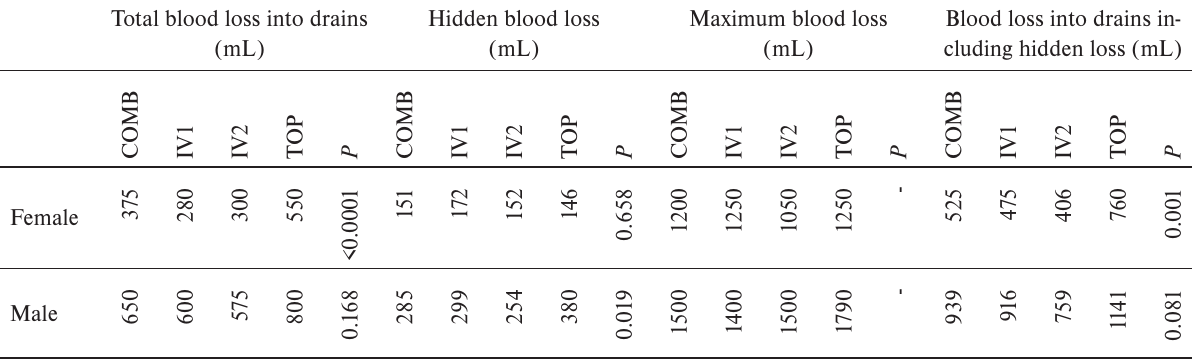
TOP, topical administration of TXA; COMB, combination of topical and intravenous administration of TXA; IV1, single intravenous administra- tion; IV2, two intravenous doses of TXA; P ,